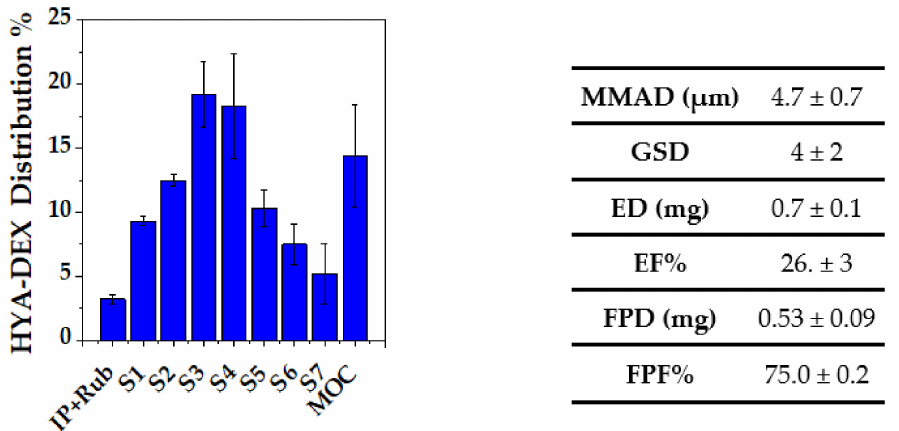
Figure 11. HYA–DEX distribution in the NGI apparatus upon nebulization. The table reports the aerodynamic parameters calculated from the distribution values: MMAD = Median Mass Aerody- namic Diameter; GDS = Geometric Standard Deviation; ED = Emitted Dose; EF = Emitted Fraction; FPD = Fine Particle Dose; FPF = Fine Particle